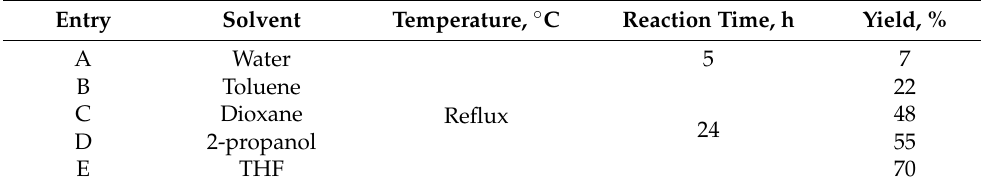
Table 1. Reaction conditions for the synthesis of compound 2